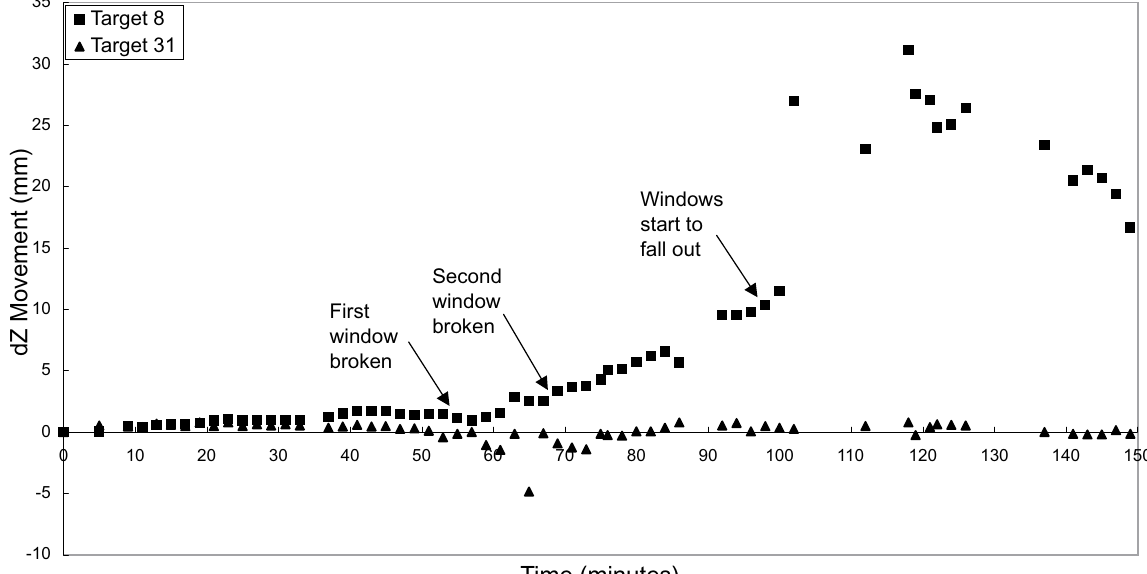
Fig. 7. Displacement-time plot of selected targets for the Cardington corner room fire